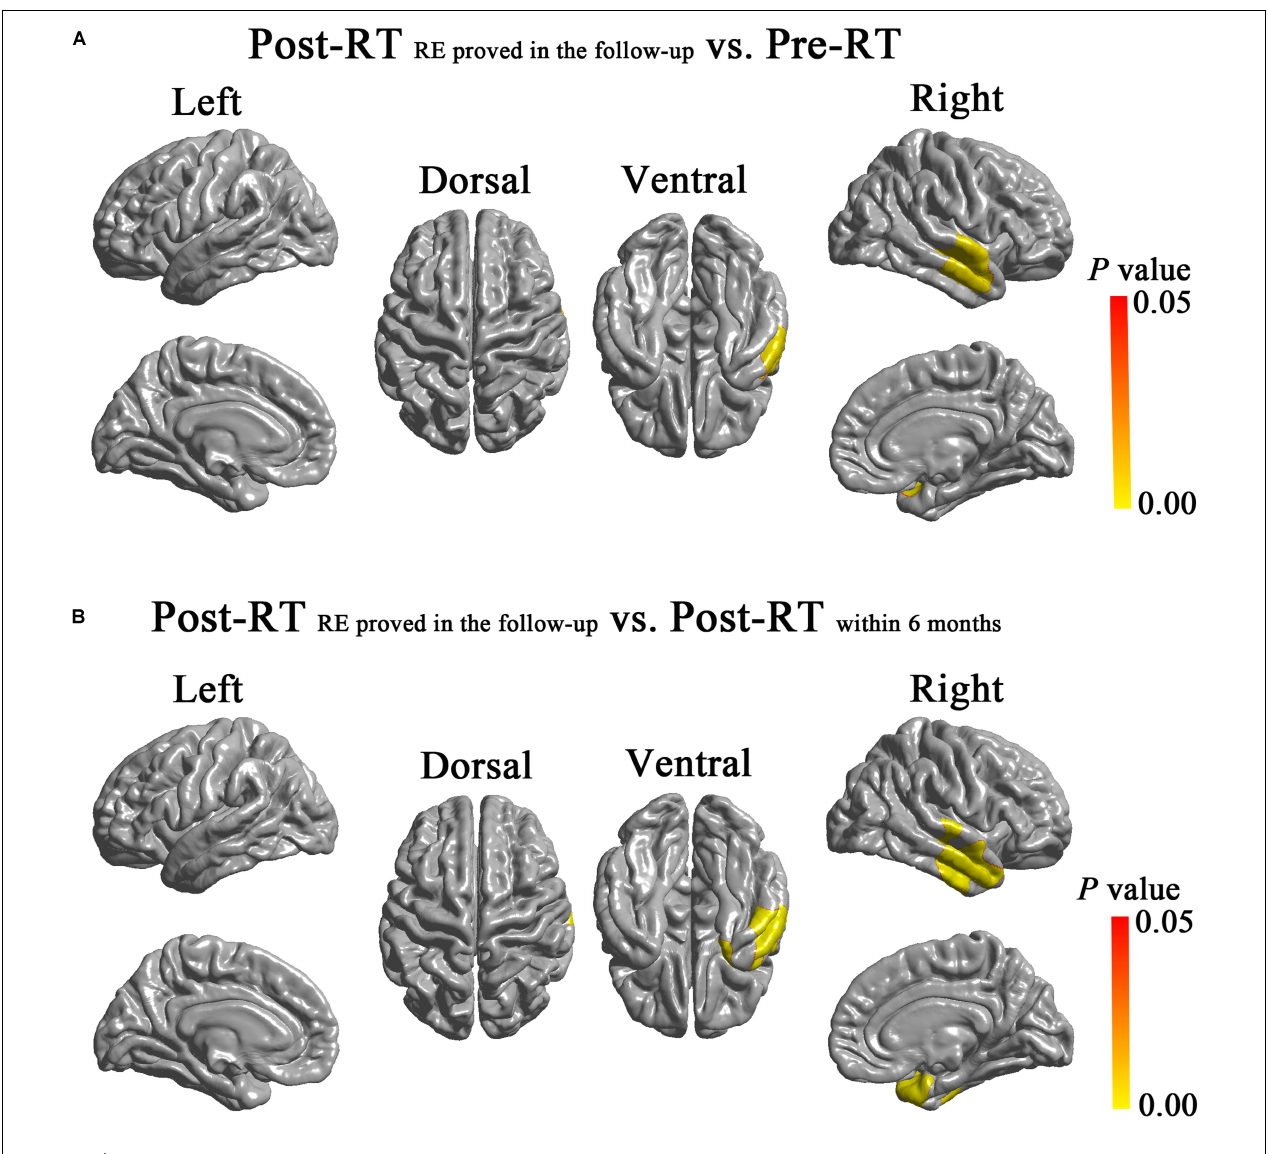
FIGURE 3 | Between-group differences in cortical surface area. Compared with the Pre-RT group, patients in the Post-RT REprovedinfollow - up group showed significantly increased surface area in the right anterior temporal lobe, including the middle and superior temporal gyrus (A) . Compared with Post-RT within6 months patients, the Post-RT REprovedinfollow - up patients showed significantly increased surface area in the right TP, the middle and superior temporal gyrus (B) . Colored areas denote regions where a significant difference in cortical surface area was observed between the indicated groups. Differing hues within each colored area denote statistical confidence in the observed differences expressed as P -value, according to the attached P -value color